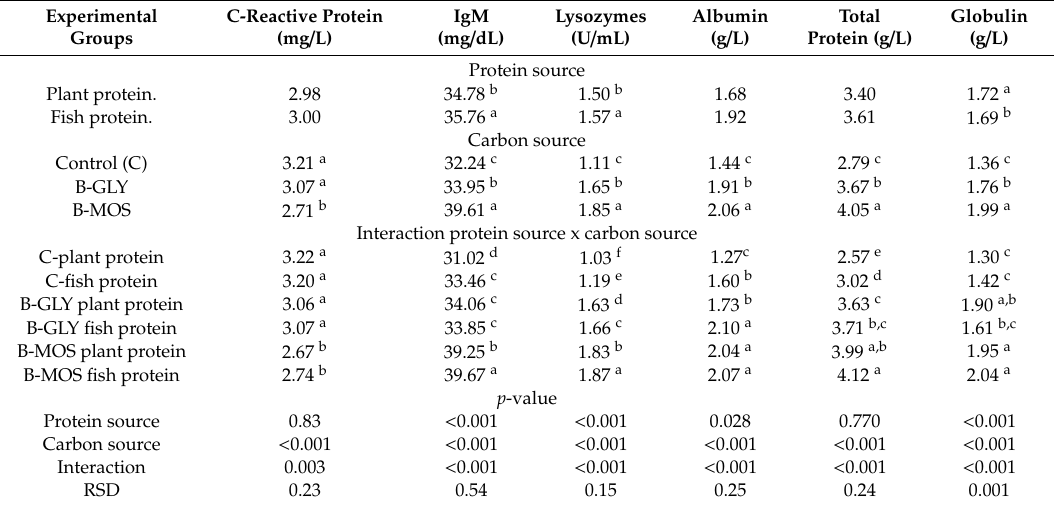
Table 7. The e ff ect of di ff erent dietary protein sources and carbon sources on Nile tilapia ( O. niloticus) serum immunity parameters.